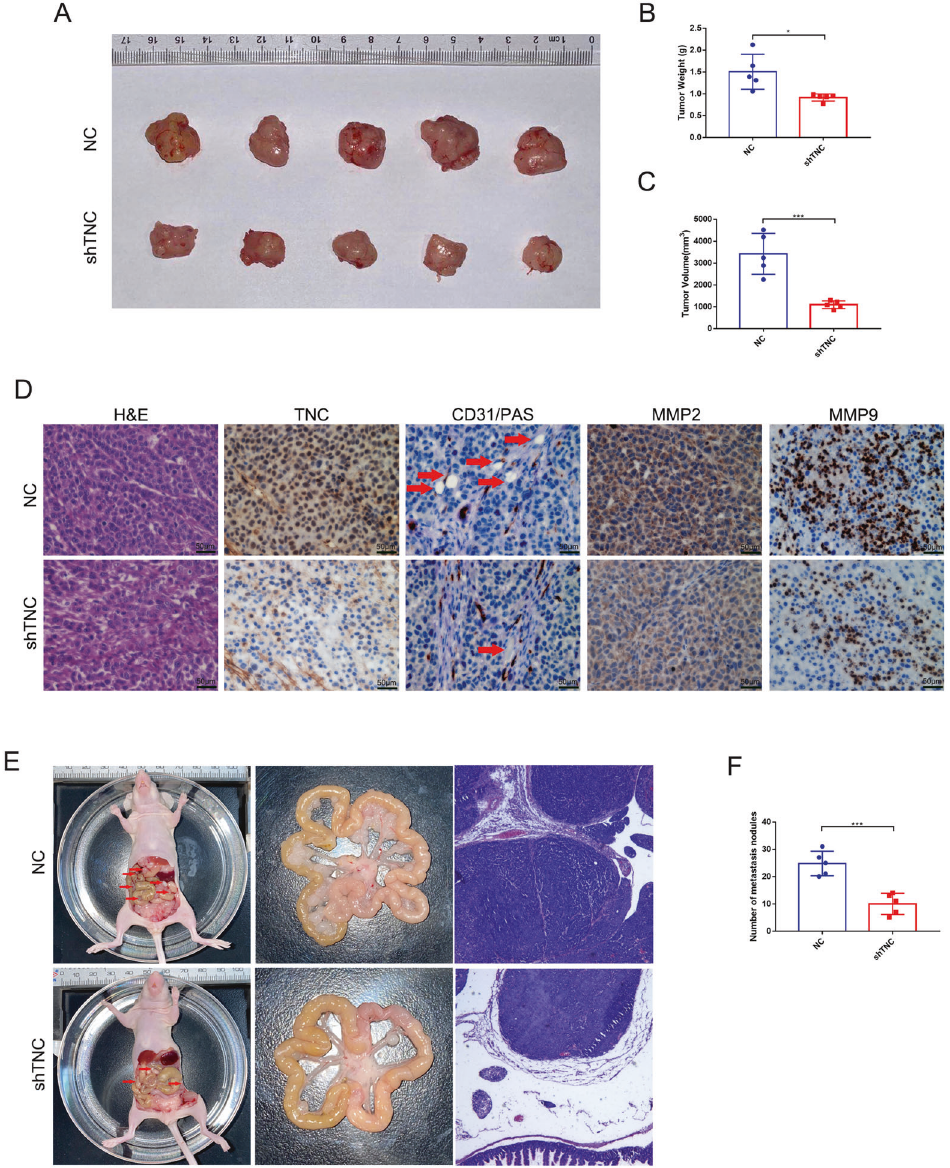
Fig. 6 TNC knockdown inhibited tumor growth and peritoneal dissemination in vivo. A Image of tumors of mice in the NC and shTNC groups. B Volume of tumor of mice in the NC and shTNC groups. C Weight of tumor of mice in the NC and shTNC groups. D H&E, TNC, VM (CD31 − /PAS + ), MMP2 and MMP9 staining in NC and shTNC xenograft tissues. E Representative intestines in nude mice. F The quanti fi cation of metastases in nude mice was counted. Results were shown as mean ± SD of three independent experiments; each experiment was performed in triplicate. * P < 0.05; *** P <